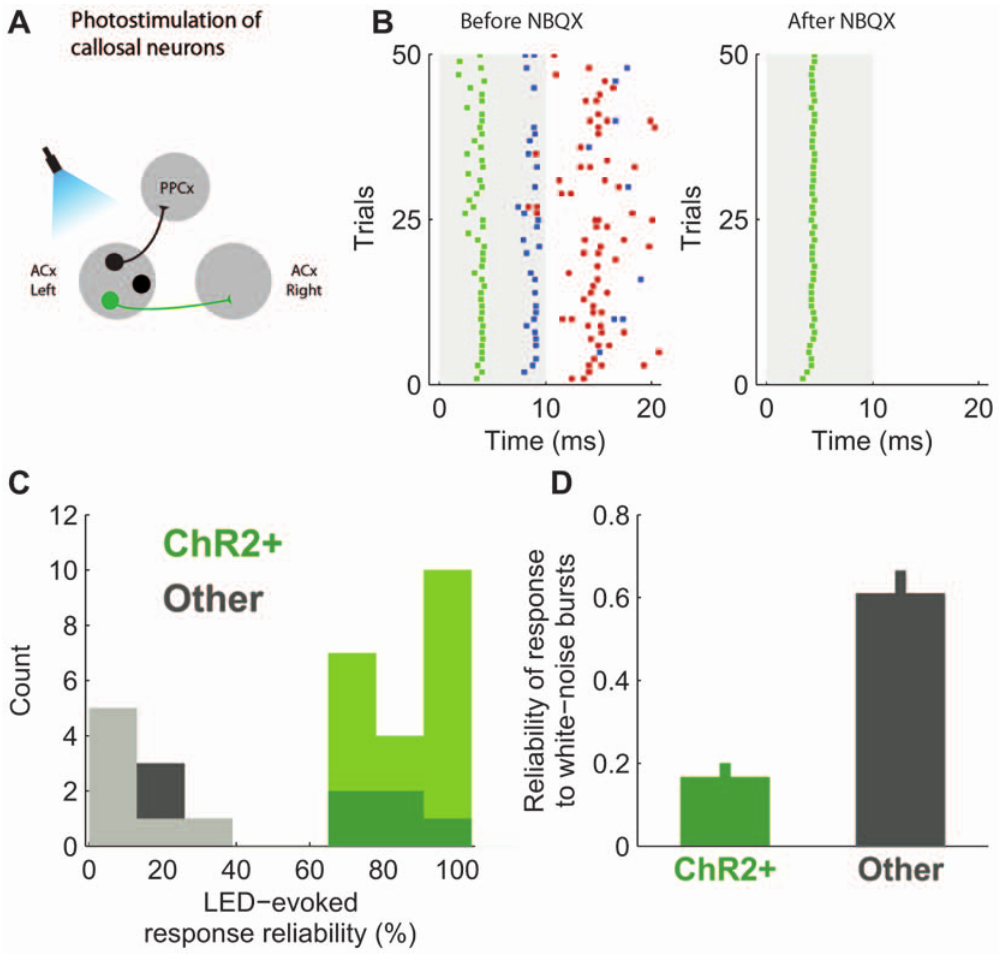
Figure 5. In vivo photostimulation of callosally projecting auditory cortex neurons. ChR2 expression in rat auditory cortex neurons can be used to tag and identify this neuronal population during in vivo recordings. (A) Callosally projecting neurons in the rat auditory cortex were labeled with ChR2 via retrogradely HSV1-mediated transfection; (B) Light-evoked activity of three well-isolated single units recorded simultaneously is shown as rasters. Each unit is color-coded ( green, blue, red ). After blocking fast glutamate (AMPA) receptors (left) with the selective antagonist NBQX, only the shortest latency unit ( green , right) continued to show light-activated activity. This indicates that activity in the other two units was indirect, i.e. synaptic, and therefore blocked by NBQX. (C) Population histogram showing that ability to follow light flashes at higher repetition rate (5 Hz, ISI=200 ms, 10 ms LED pulses) cleanly separated recordings into two classes, which we interpret as direct (ChR2-positive; dark green: single units responding after NBQX application) and synaptic (ChR2-negative; dark gray: single units not responding after NBQX simulation; light gray: multiunit recordings). The x-axis shows the spiking response reliability, computed as the fraction of trials in which the firing rate in 40 ms after the start of the second pulse of 5 Hz LED trains was greater than in the 40 ms immediately preceding the pulse. (D) Callosally projecting neurons (ChR2 + ) are non- responsive to white noise stimulation, showing different response reliability from the average population (Other). Reliability was computed as the fraction of trials in which the firing rate in 40 ms after sound onset was greater than in 40 ms immediately preceding the sound. Error bars